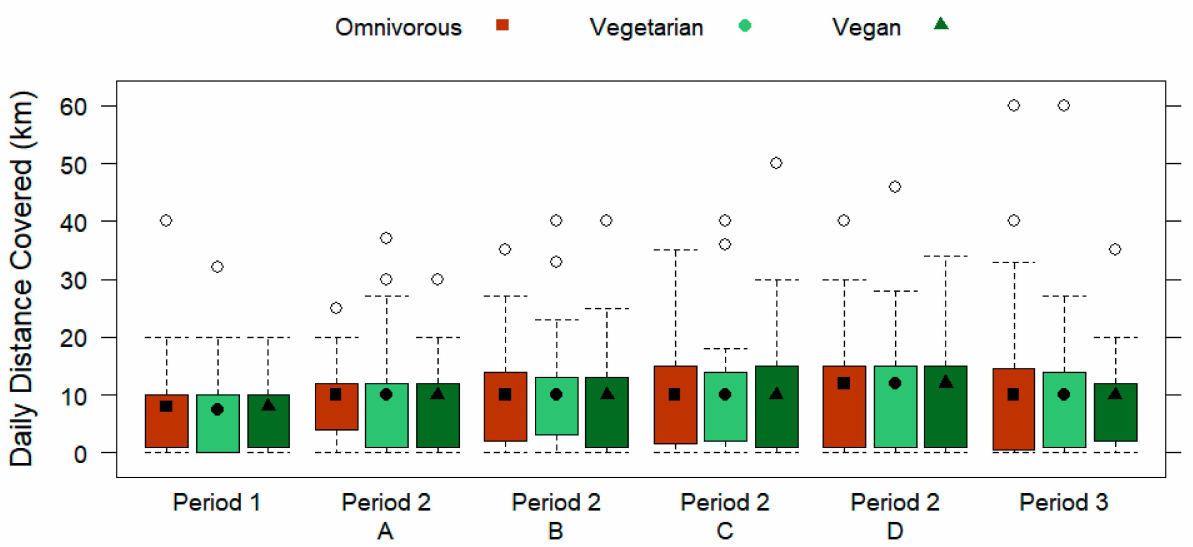
Figure 6. Daily distance covered (km; displayed by three training periods, including the A, B, C, and D training types of period 2) of omnivorous, vegetarian, and vegan runners. Data are presented by box